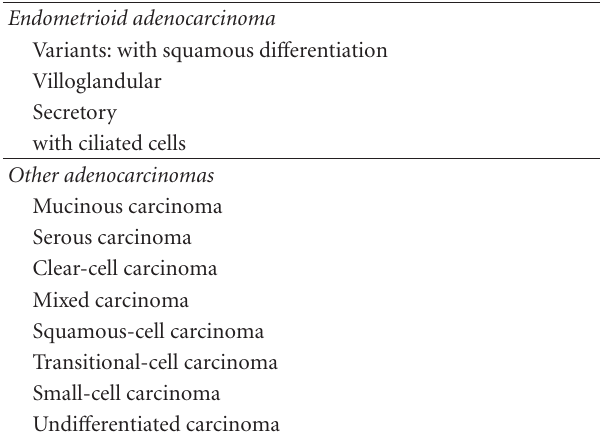
Table 1: WHO histological classification of endometrial carcinoma. Endometrioid